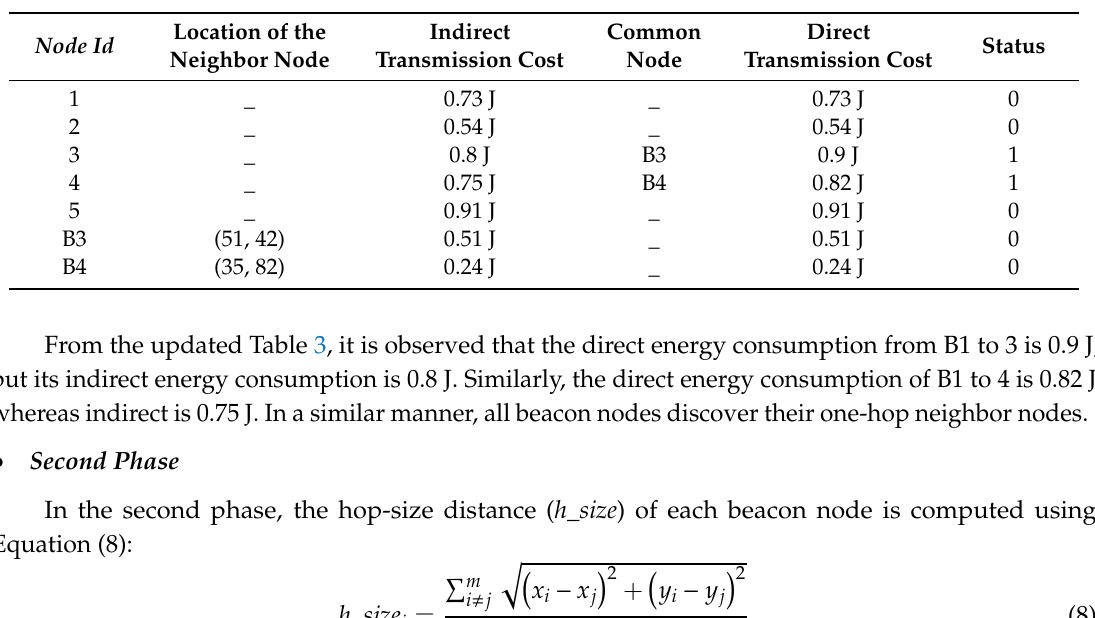
Table 3. Vicinity table of node B1 after finding Com BN